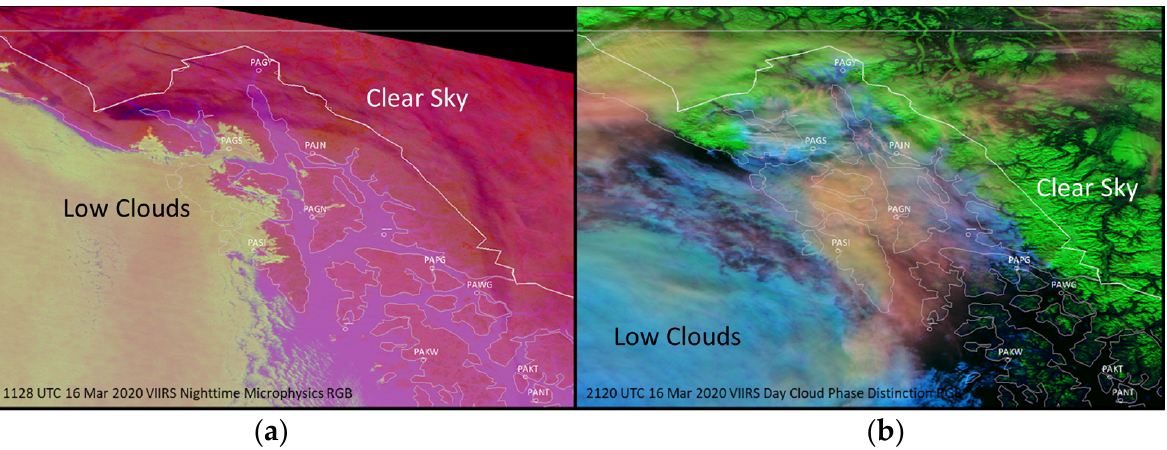
Figure 3. 1128 UTC 16 March 2020 VIIRS Nighttime Microphysics RGB imagery ( a ) and 2120 UTC 16 March 2020 VIIRS Day Cloud Phase Distinction RGB imagery ( b ). See text for image interpreta-